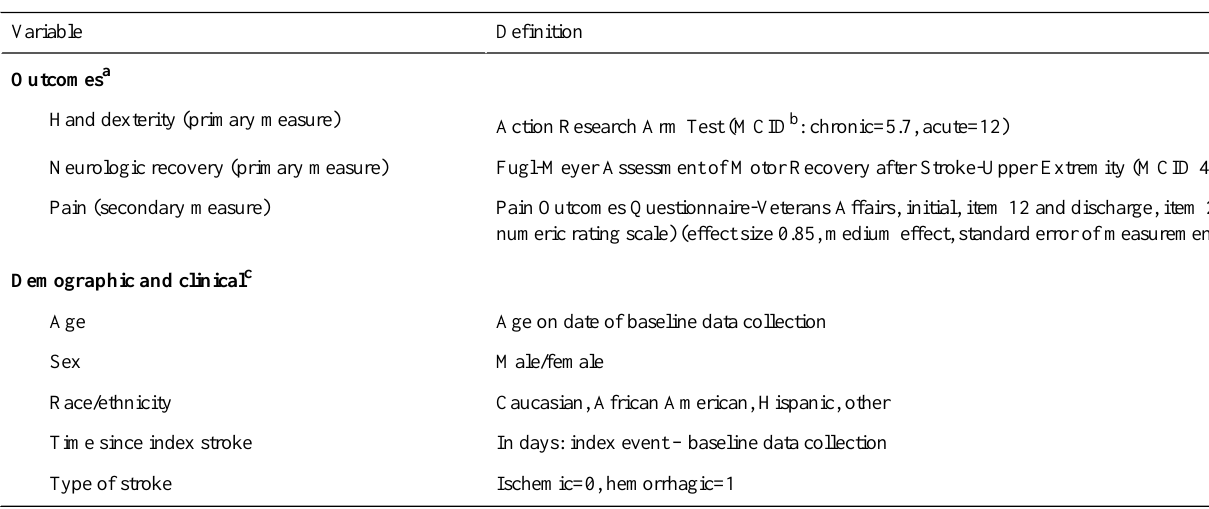
Table 1. Outcome variables and